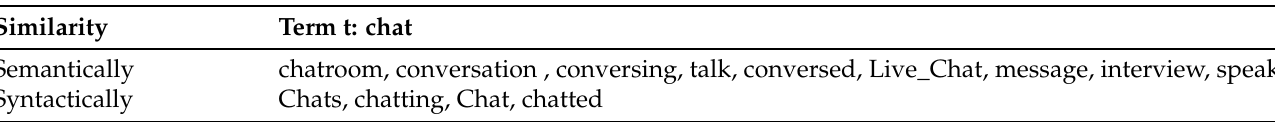
Table 1. Word expansion example based on the pre-trained word embedding model.